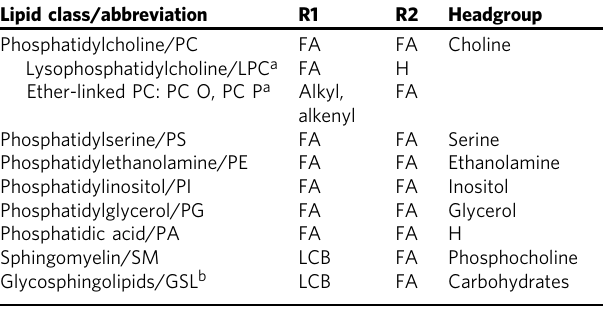
Table 1 The most common lipid classes in membranes Lipid class/abbreviation